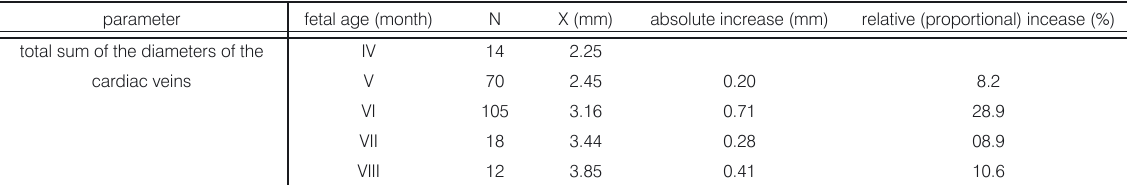
Table 6. The increases (absolute and proportional-relative) of the investigated linear features in fetal subjects of both sexes and the growth index determined based on the differences between consecutive age groups. X – average, N- parameter